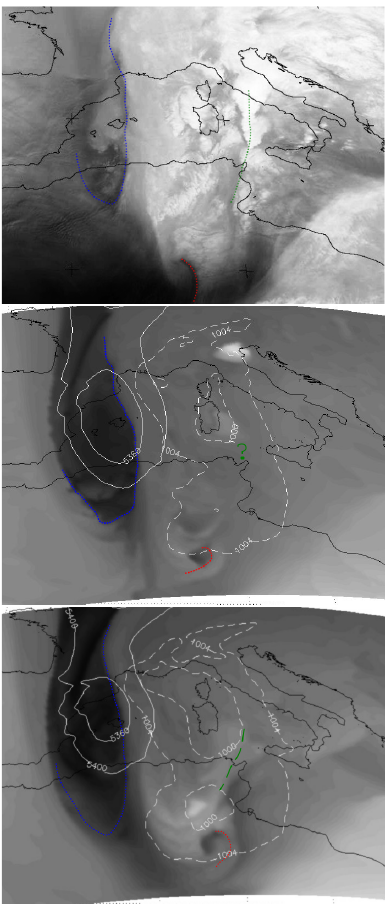
(Fig. 7, bottom panel, green dashed line) in correspondence with the observed rain band (Fig. 7, top panel, green dotted line), but not in the QBOLAM one (Fig. 7, middle panel).